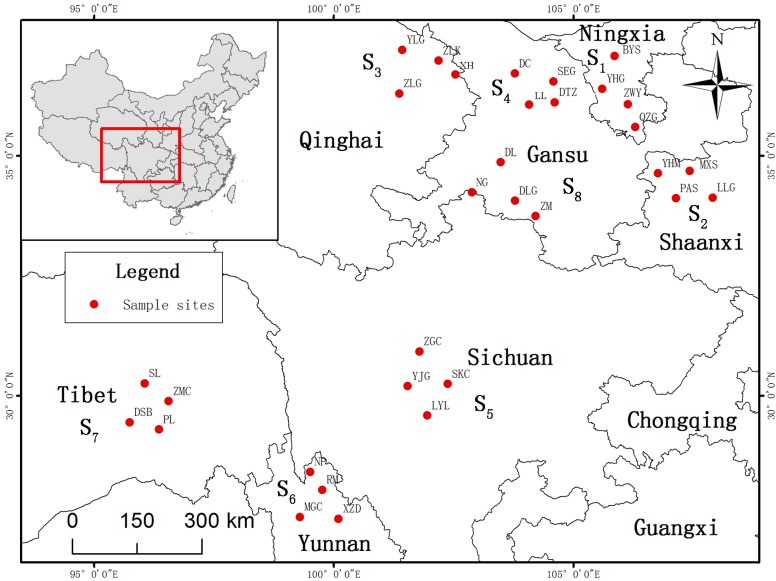
Growing locations of the 32 S. hexandrum populations involved in seven provinces of China sampled for this study.Maps generated using ArcGIS 10.0 (ESRI Inc. 2014).